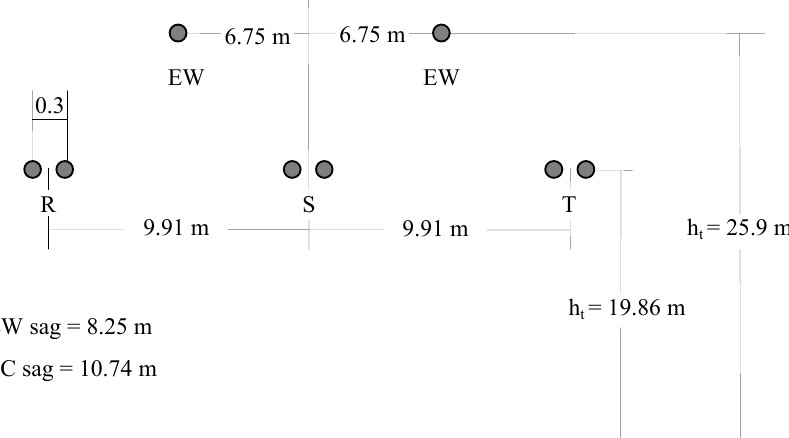
Figure 5. Single circuit OHL tower